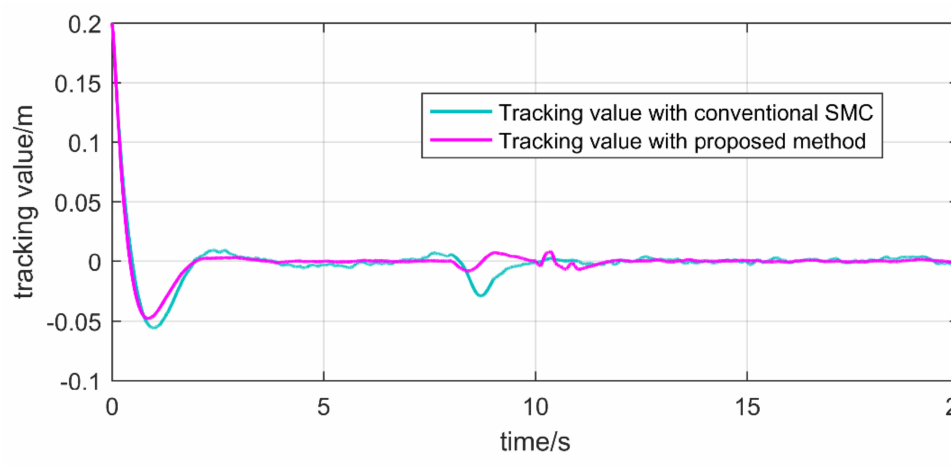
Figure 6. Trajectory tracking of position z